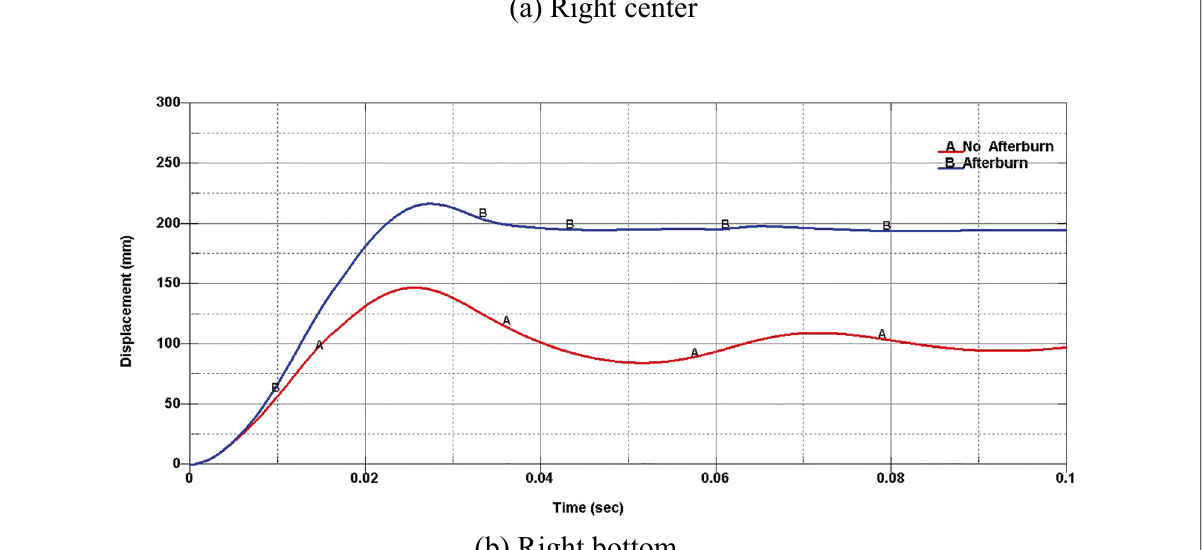
Fig. 28 Comparison of displacement over time.